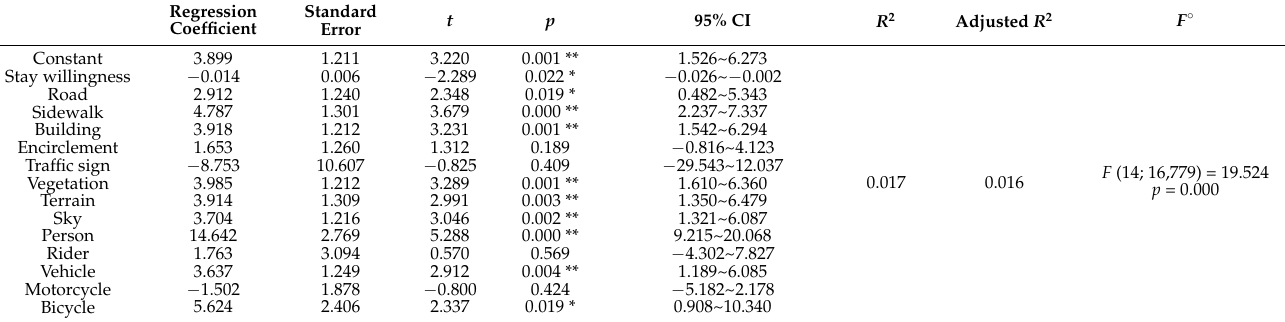
Table 7. OLS analysis with indoor environment rating as the dependent variable ( n =